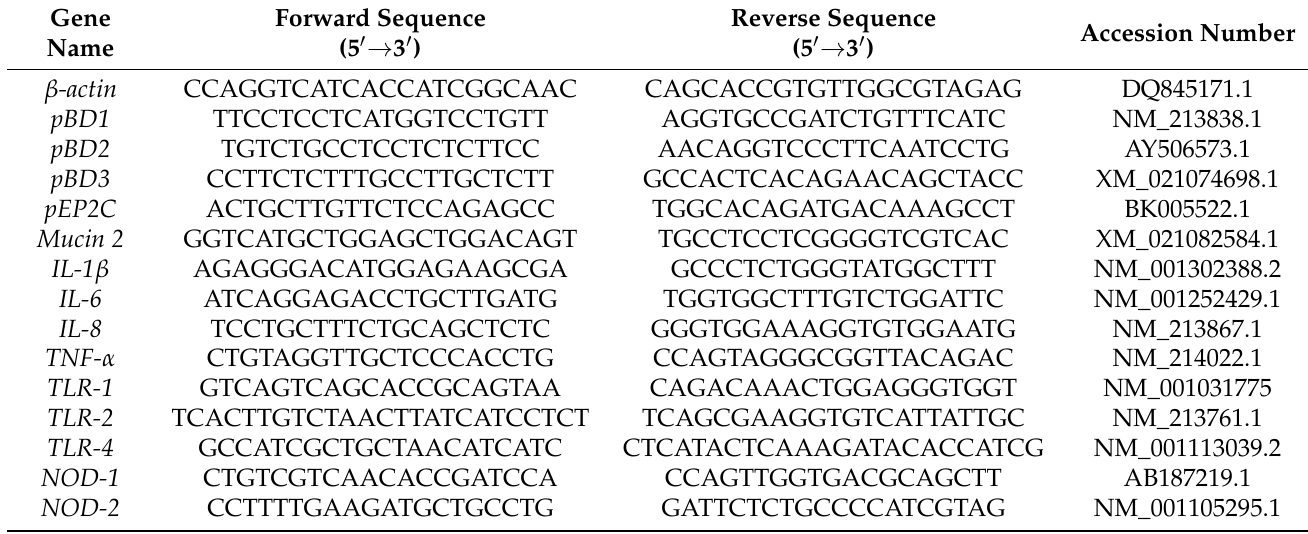
Table 1. Primers used for quantitative real-time